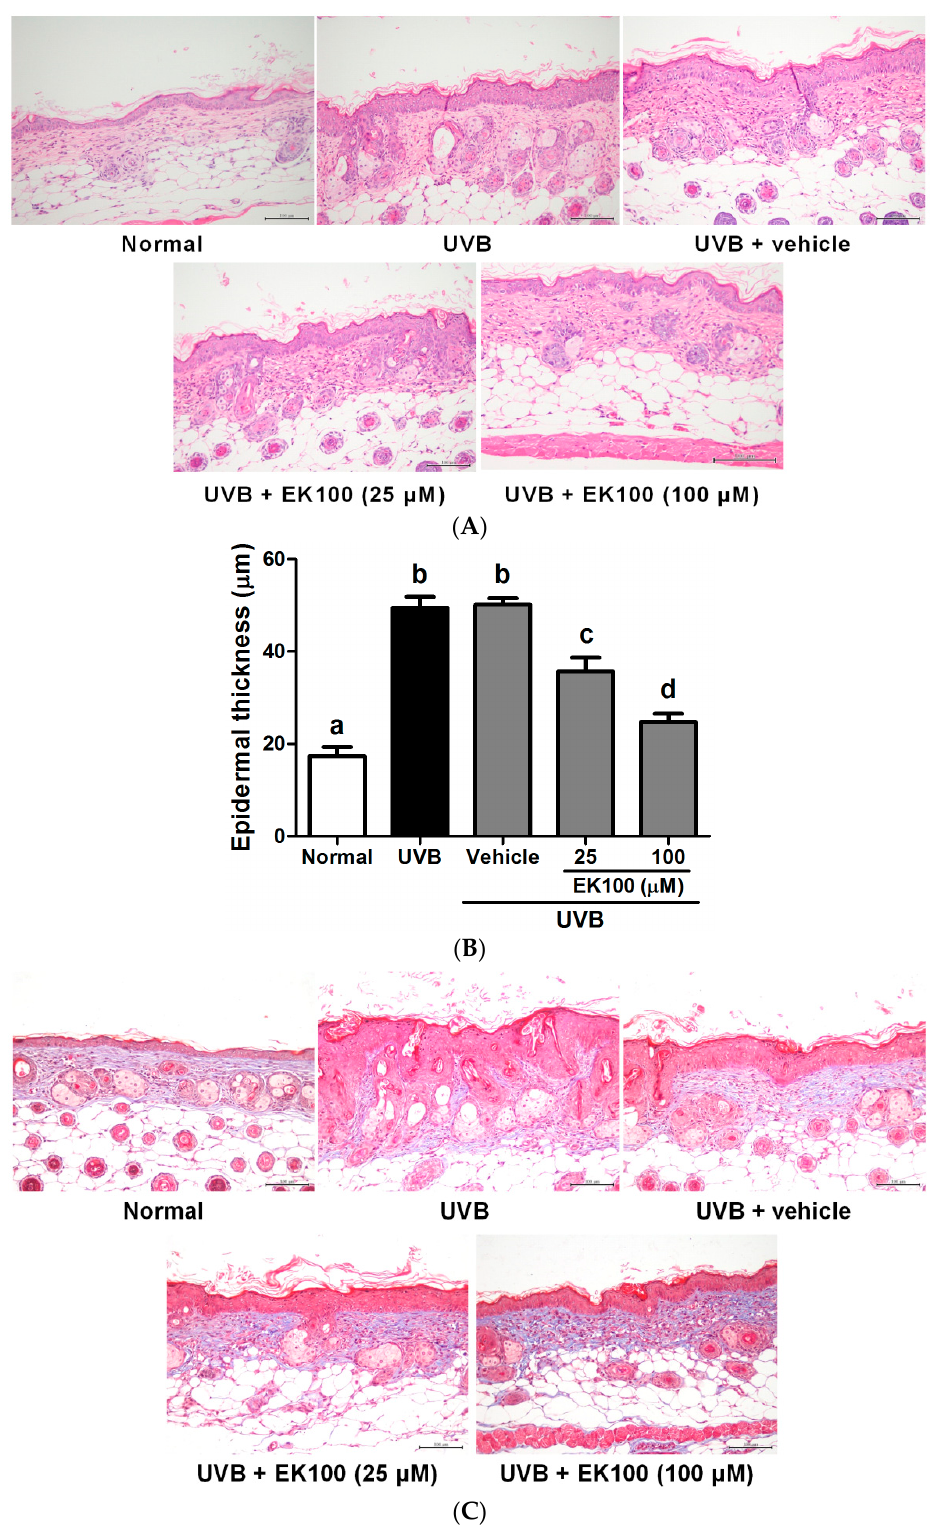
Figure 5. ( A ) Light micrographs of histological sections stained with hematoxylin and eosin in hairless mice; ( B ) Effect of EK100 on epidermal thickness in chronic UVB-irradiated hairless mice in the 10th week. The epidermal thickness of the mice was significantly increased by UVB exposure and reduced by EK100 treatment. a–d : Values not followed by a common letter are significantly different ( p < 0.05); ( C ) Light micrographs of histological sections stained with Masson trichrome in hairless mice. Collagen fibers were stained in blue. UVB significantly increased the thickness and reduced the collagen content in the mouse skin. EK100 reduced the epidermal thickness and increased the collagen content.